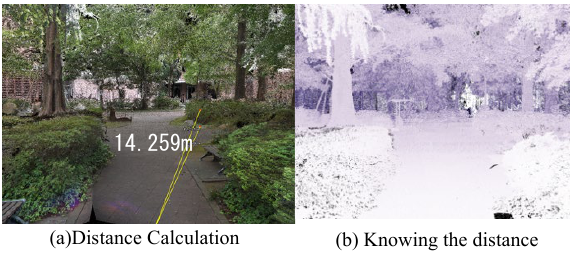
Figure 4 . Quantitative classification of immediate,